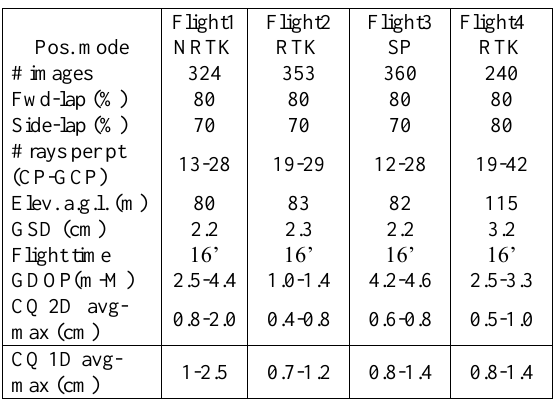
Table 1. Block and GNSS data summary of the four flights